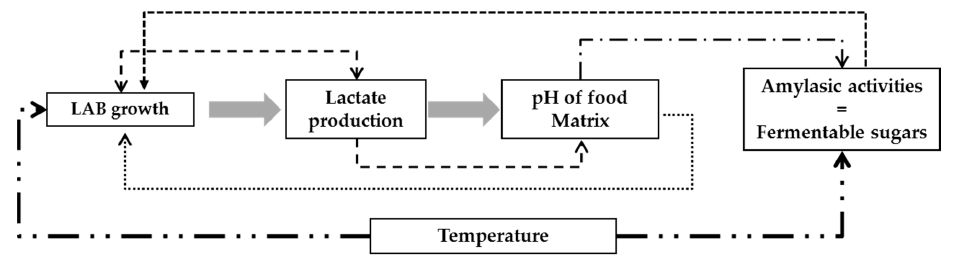
Figure 1. Schematic representation of the global fermentation model of gowé. Each block hosts the model of one process, and interactions are represented by the arrows with dotted lines. LAB: lactic acid bacteria.